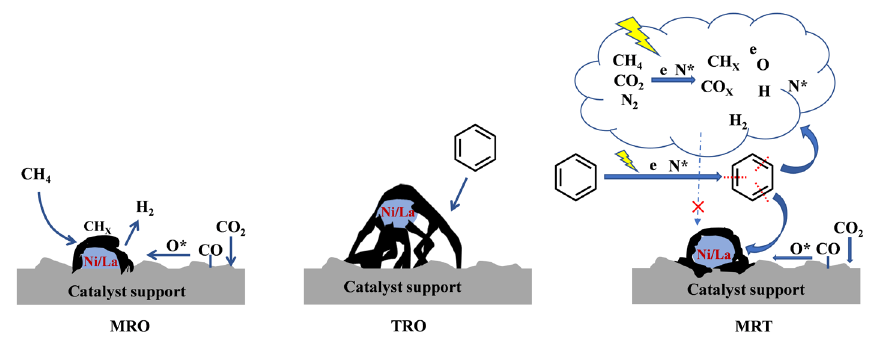
Figure 5. Reaction mechanism of the catalytic process.